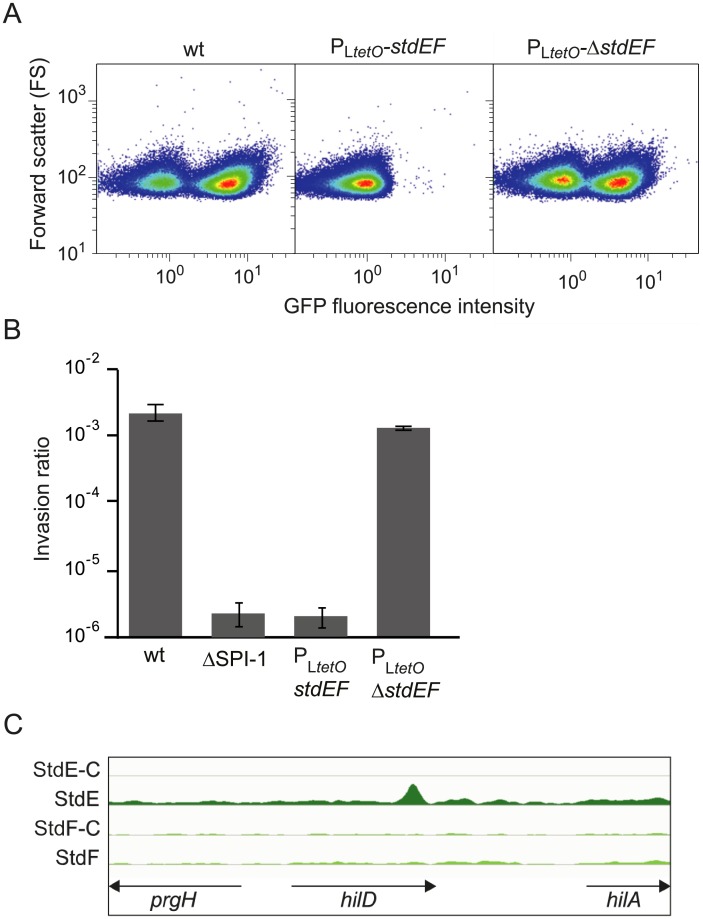
SPI-1 control by StdE.A. GFP fluorescence intensity in strains sipB::gfp (SV7884), sipB::gfp PLtetO-stdEF (SV7885), and sipB::gfp PLtetO-ΔstdEF (SV78869). B. The invasion ratios (output bacteria/ input bacteria) of epithelial HeLa cells by four Salmonella strains are represented: the wild type (wt), a strain with a deletion of SPI-1 (ΔSPI-1), a strain carrying the PLtetO-stdEF construct, and a strain carrying the PLtetO-ΔstdEF construct. C. StdE binding to the hilD coding region. StdE-C and StdF-C indicate binding peaks found for the mock IP-sample.